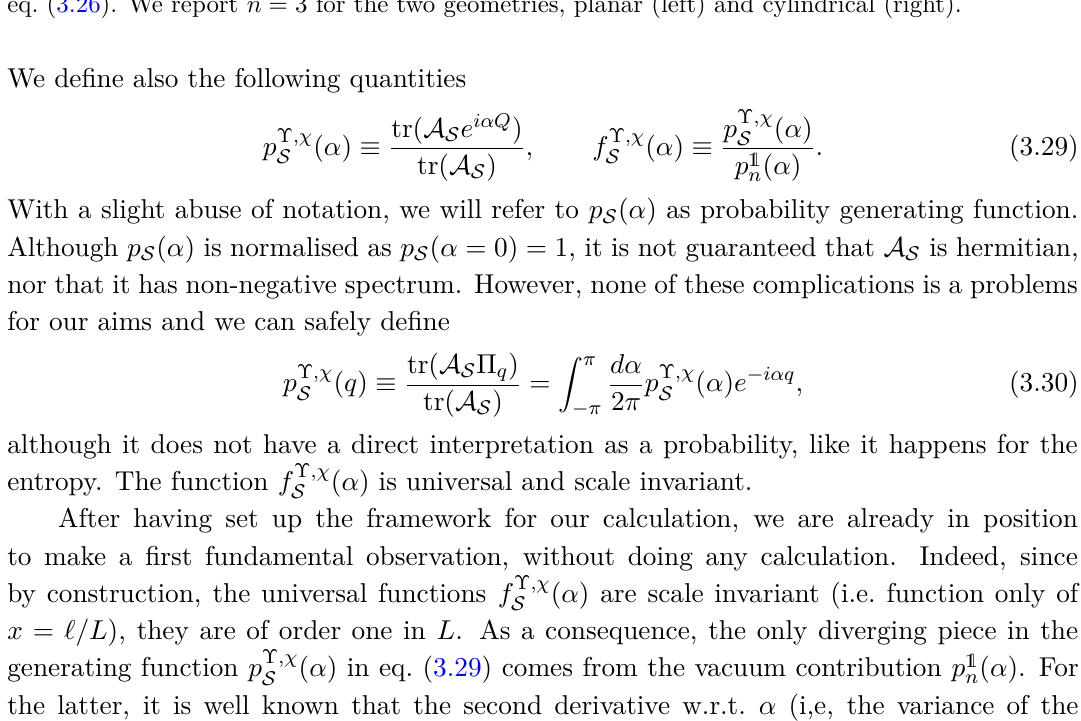
Figure 1 . Points where the operators are inserted in the correlations